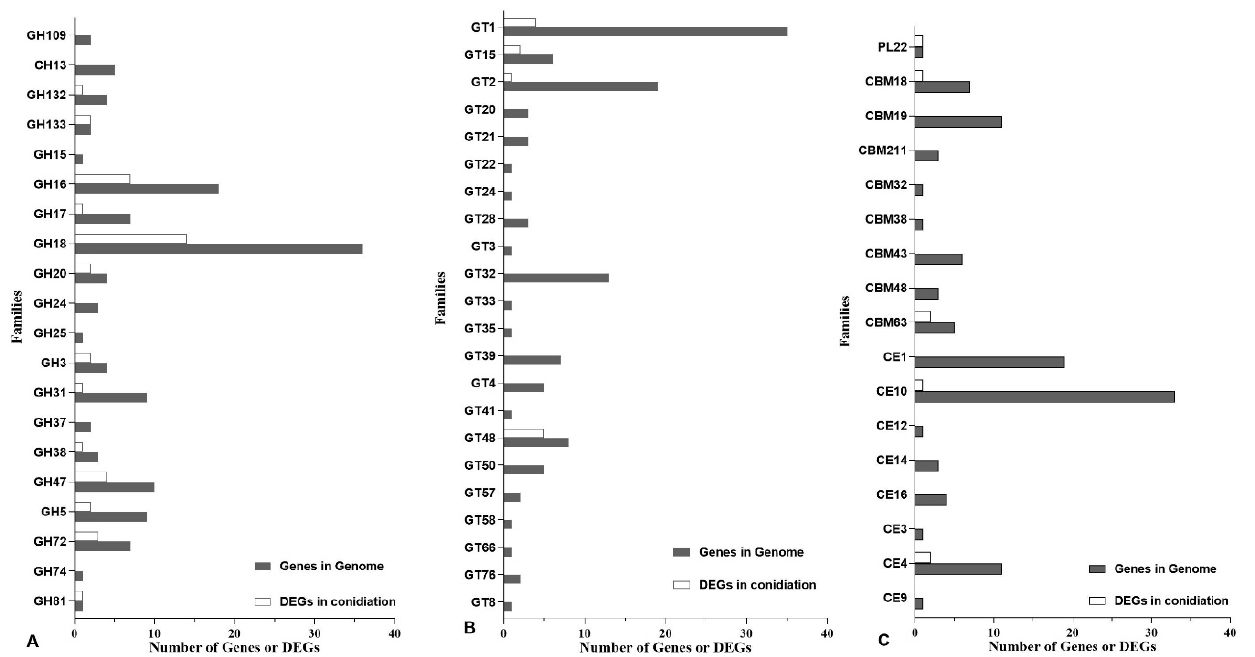
Figure 4. Gene numbers of CAZyme-encoding genes in the C. obscurus genome and the related differentially expressed genes (DEGs) in conidiation. ( A ) glycoside hydrolase (GH) family; ( B ) glycosyl transferase (GT) families; ( C ) carbohydrate esterase (CE), carbohydrate-binding module (CBM), and polysaccharide lyase (PL) families. CAZyme families were identified with the CAZyme database (http://www.cazy.org, accessed on 14 March 2022).